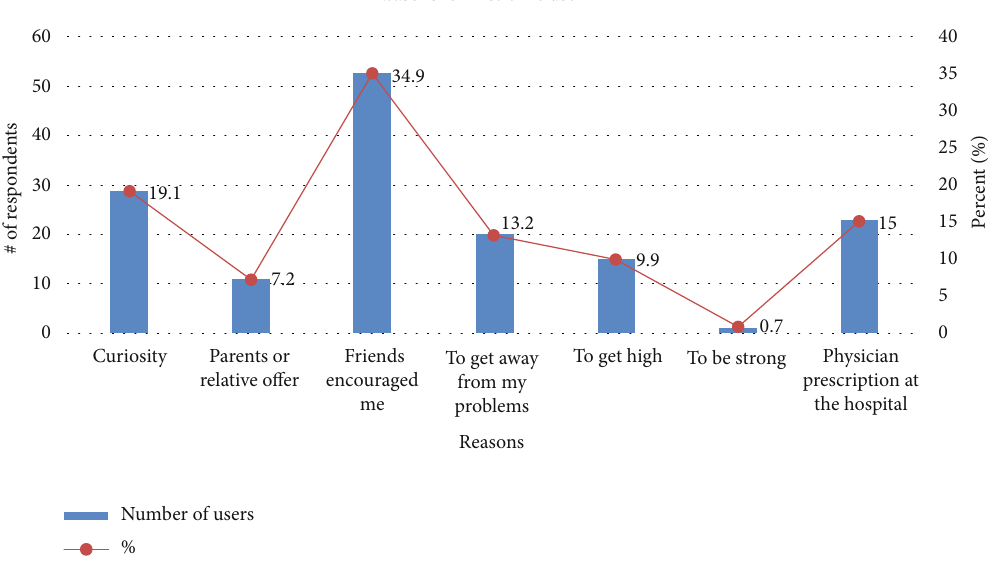
Figure 1: Purpose for the intake of tramadol for the fi rst